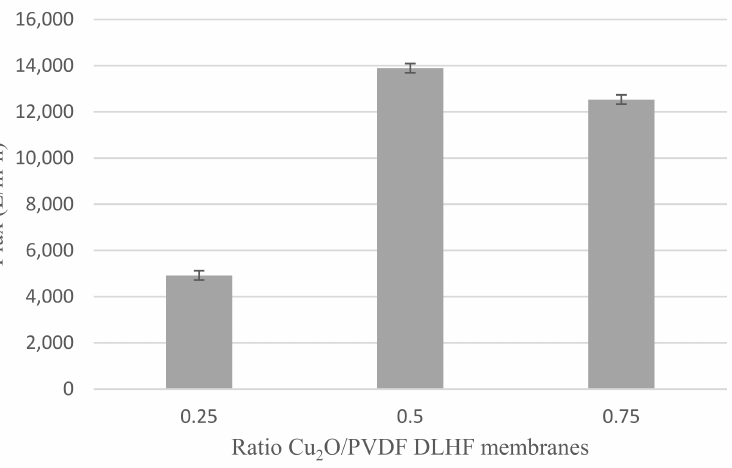
Figure 9. Water flux of 0.25, 0.5 and 0.75 Cu 2 O/PVDF DLHF membranes with outer dope flowrate 6